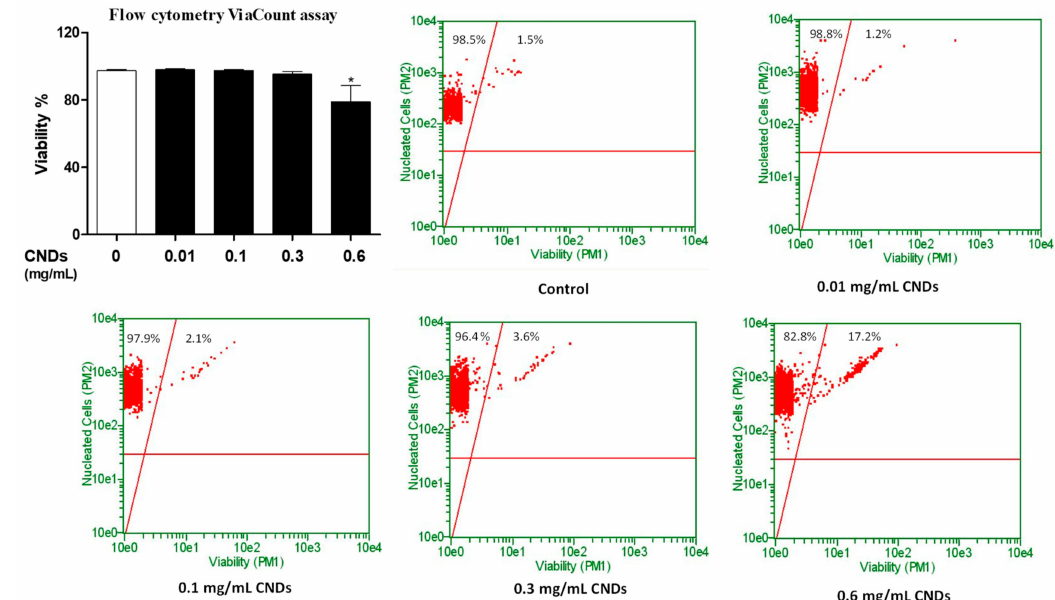
Figure 4. Effect of CNDs on cell viability (ViaCount). THP-1 cells were treated with 3 ng/mL TPA in the presence or absence of 0.01, 0.1, 0.3, or 0.6 mg/mL CNDs in RPMI media for 72 h, upon which media was refreshed. Then, cells were left to incubate for another 72 h, after which cells were harvested and treated with ViaCount reagent. Then, a viability analysis was performed using a Guava ® easyCyte™ Flow Cytometer (Single Sample System). All data represent mean ± SEM. ( n = 3, *, p < 0.05 vs.